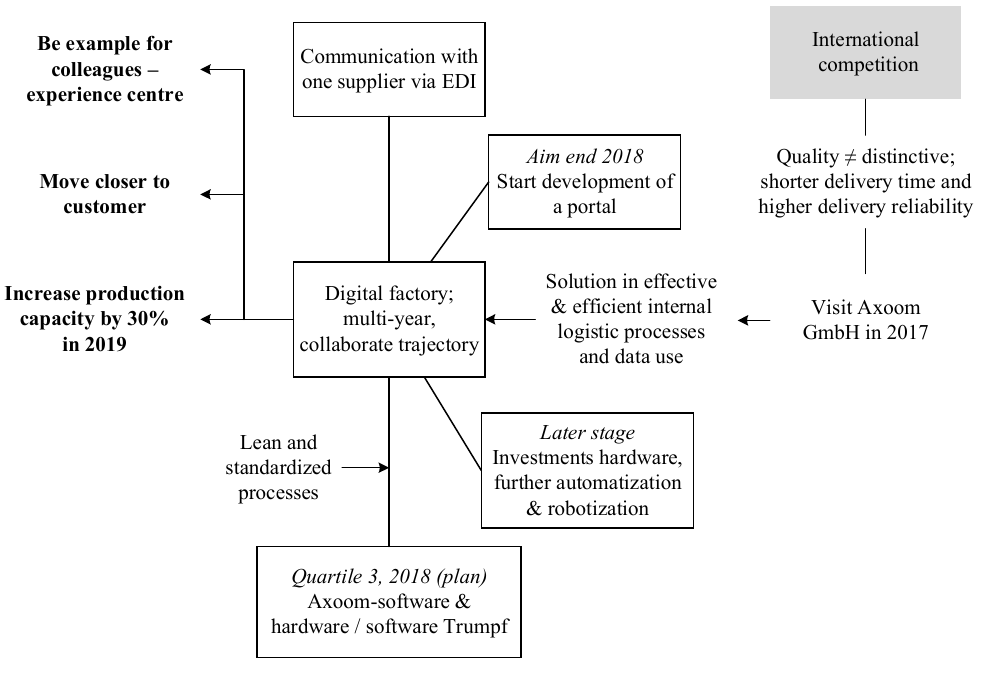
Figure A3. Flow chart for De Cromvoirtse.